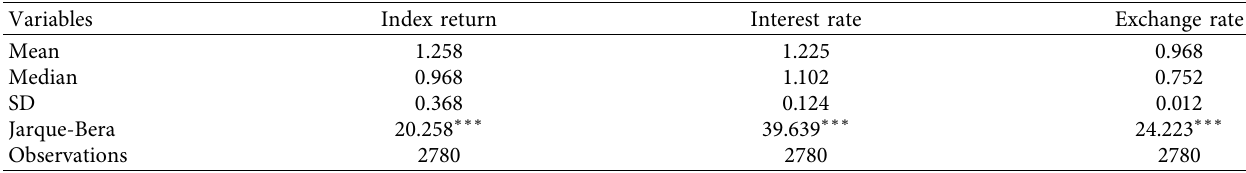
Table 3: Descriptive statistics for Turkey.